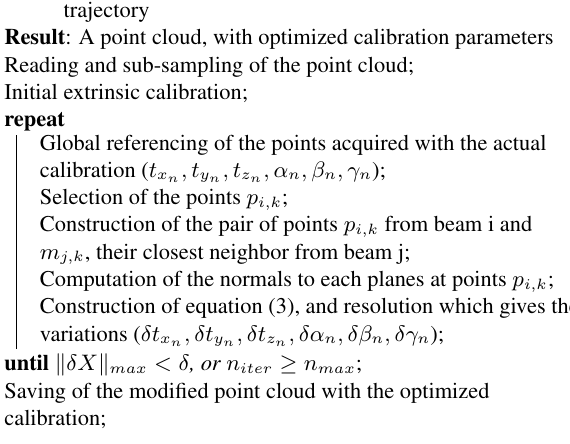
Algorithm 1: Iterative linear optimization for the parameters of the extrinsic